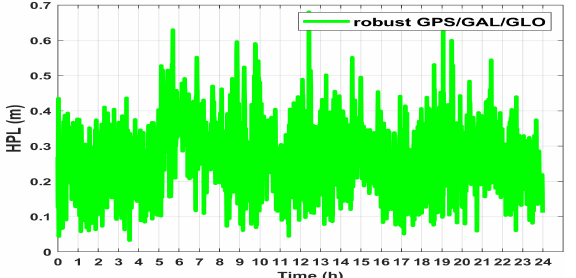
Figure 5. HPLs of robust GPS/GAL/GLO data at station